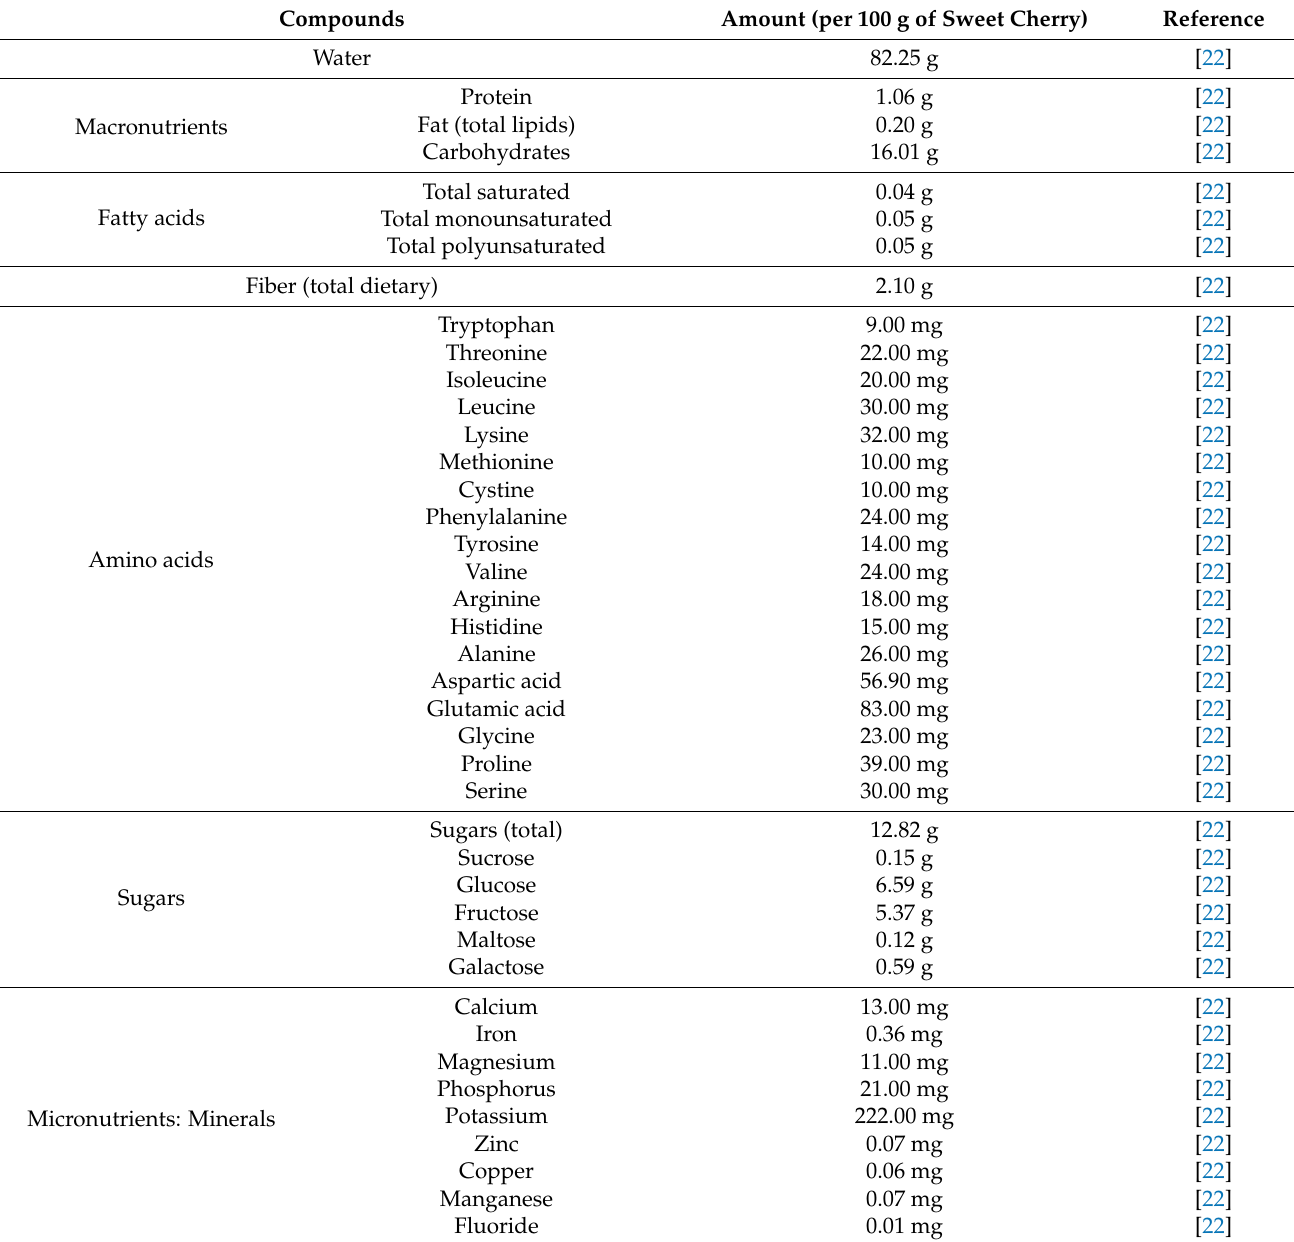
Table 1. Main nutrients, phytochemicals and bioactive compounds found in sweet